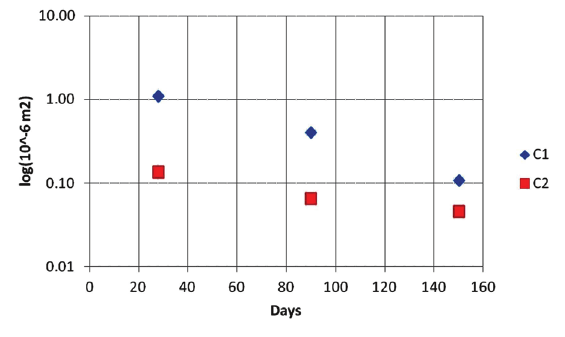
Fig. 6. Air permeability change in time of C1 and C2 concrete